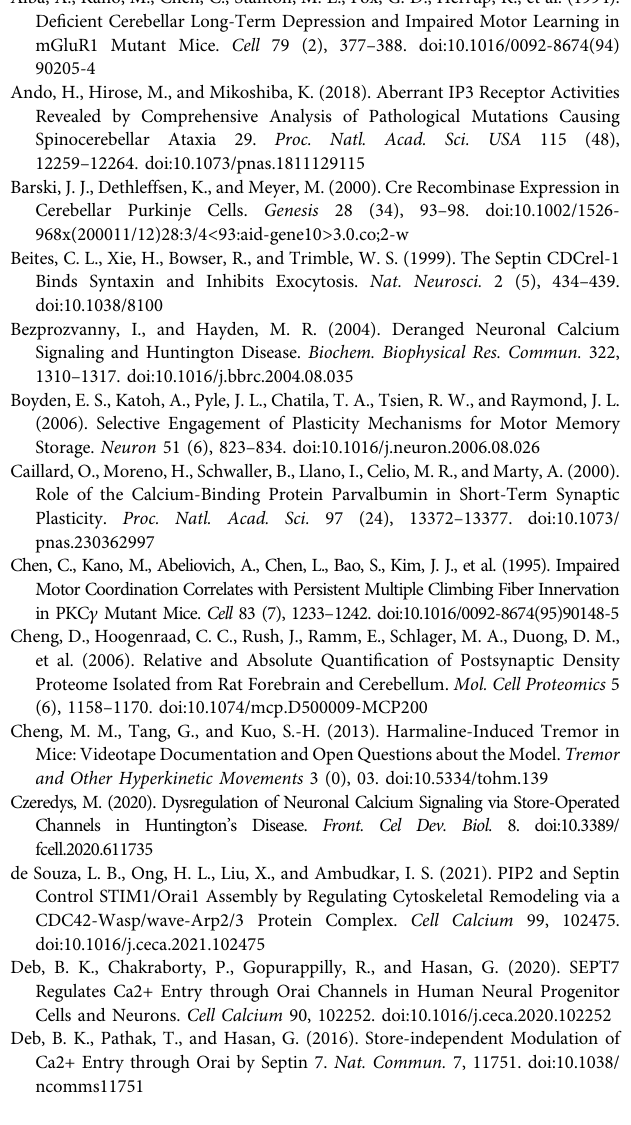
Supplementary Figure S1 | Analysis of gene expression in SEPT7 – STIM1 knockout Purkinje neurons (related to Figure 3 ) (A) Bar graph showing relative fold changes in expression levels of the indicated genes of various control genotypes of STIM1 PKO ; SEPT7 PHet . Red asterisks above each bar represent statistically signi fi cant groups compared between STIM1 PKO (pink bars) and STIM1 fl ox/ fl ox ; SEPT fl ox/+ (light blue bars). (B) Bar graph showing relative gene expression changes of the indicated genes ofvariouscontrolgenotypes of STIM1 PKO ; SEPT7 PKO . Red asterisks overeach bar represent statistically signi fi cant groups compared between STIM1 PKO (pink bars) and STIM1 fl ox/ fl ox ; SEPT fl ox/ fl ox (blue bars). Fold changes were normalized to GAPDH . Dataarepresentedasmean ± SEM,* p < 0.05,** p < 0.01;One-wayANOVAwithpost hoc Tukey ’ s test. All measurements are taken by qRT-PCR of cDNA prepared from RNA isolated from microdissected Purkinje layers ( n (cid:1) 3 mice for all groups and n (cid:1) 4 for STIM1 PKO ; SEPT7 PHet , age: 1-year-old mice). Itpr1 , inositol 1,4,5-trisphosphate